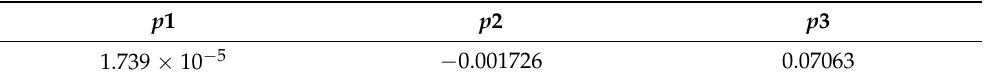
Figure 7. R 0 - T two-dimensional fitting diagram at room temperature and high temperature. Table 3. Coefficient values in the fitting expression of R 0 - T at room temperature and high